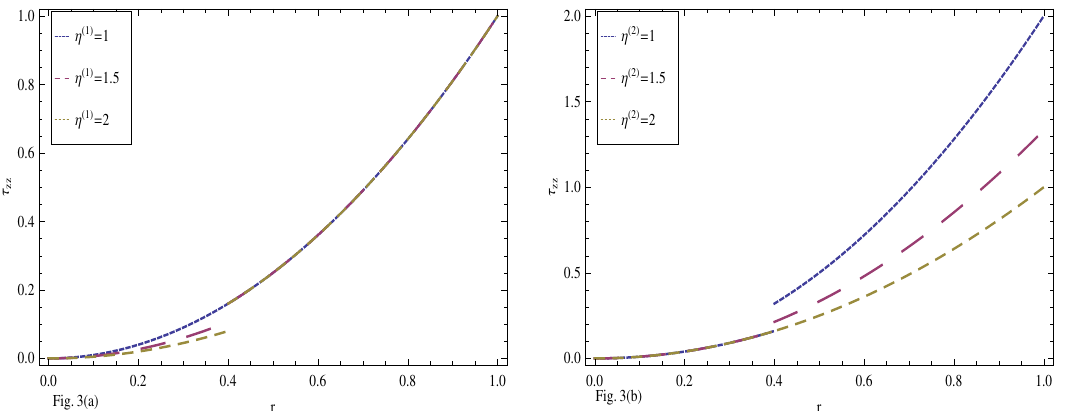
Figure 2. The effect of pressure gradient on the ( a ) shear stresses ( b ) normal stresses when ξ = 0.4.